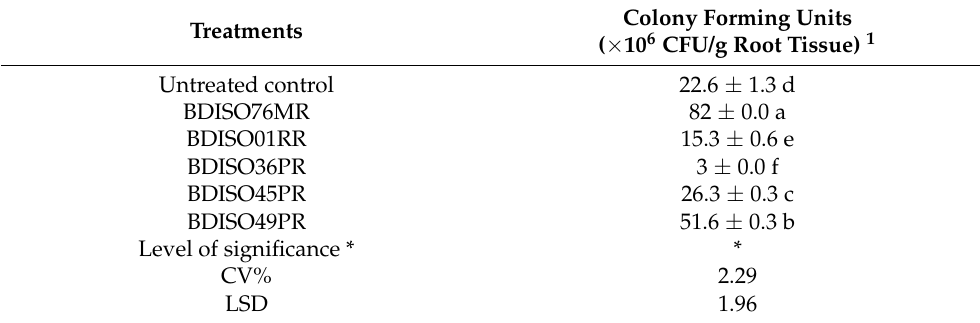
* Represents significance at a 5% level of significance. 1 Data are the averages of three replications ± SE. Values with similar letters are statistically similar. (BDISO76MR: B. subtilis , BDISO01RR: B. amyloliquefaciens , BDISO36PR: B. subtilis , BDISO45PR: B. subtilis and BDISO49PR: B. subtilis ). Untreated control: sterilized maize grains were submerged in sterile water only. 3.8. Influence of Different Bacillus sp. on Average Root and Shoot Length and Vigor Index At 7 DAS, the maximum (23 cm) root length was observed when maize seeds were treated with BDISO01RR ( B. amyloliquefaciens ) followed by BDISO45PR ( B. subtilis ) (18.17 cm), BDISO49PR ( B. subtilis ) (18.17 cm), BDISO36PR ( B. subtilis ) (18 cm), and BDISO76MR ( B. subtilis MMM1) (15.67 cm) (Table 5). On the other hand, at 7 DAS, maize seeds treated with BDISO36PR ( B. subtilis ) showed a maximum (13.17 cm) shoot length followed by